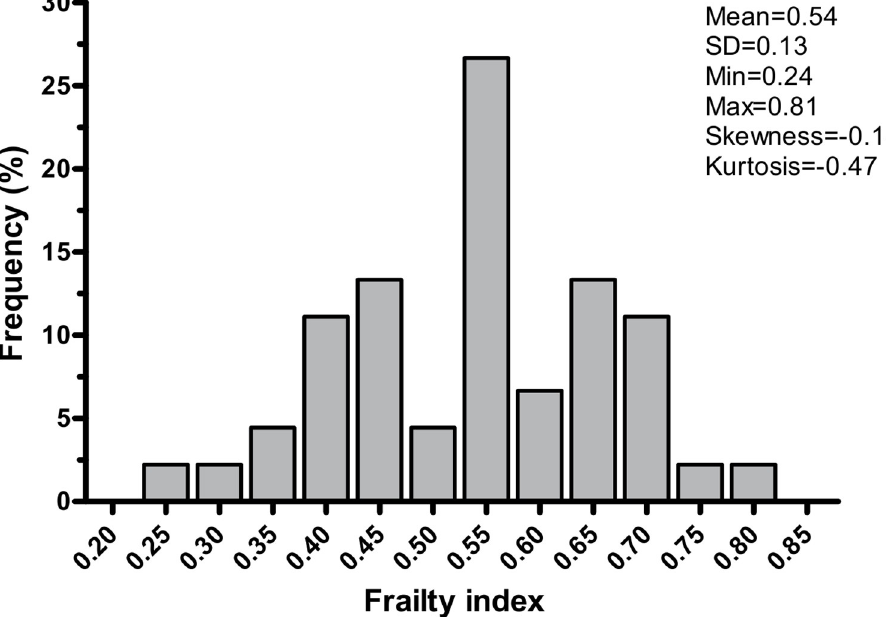
Fig 1. Normal distribution of the frailty index in the study population. SD = standard deviation.